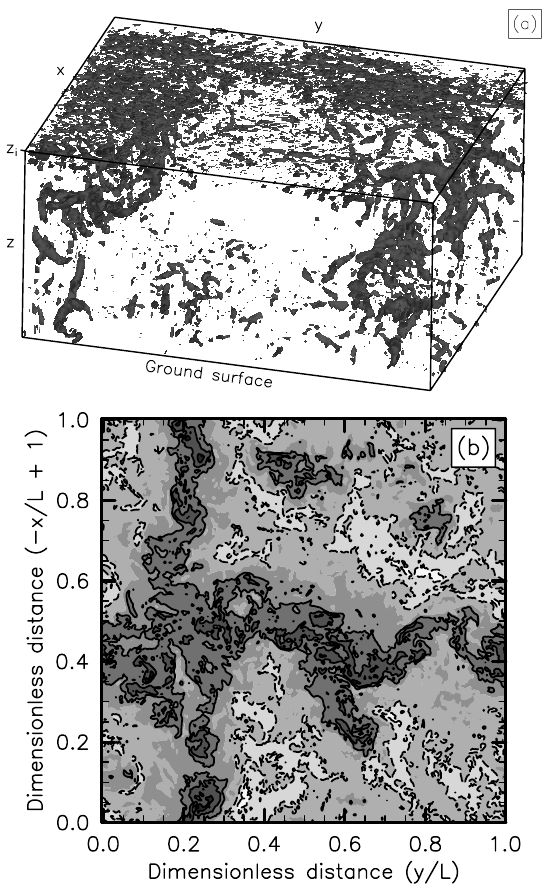
Fig. 3. (a) Iso-surface Q =0.0015s − 2 for an isolated convective cell at 15:00EST. The displayed view encompasses a horizontal domain of about 1.5km × 1.5km, the height ranging from z =0 to z i . (b) Contour plot of the dimensionless vertical velocity e w/w ∗ at the same time in the horizontal plane z = z i / 2. At the displayed time, w ∗ =1.70ms − 1 and z i =1300m. The contour lines correspond to =± 1, ± 2, ... Solid and dashed lines represent positive and e w/w ∗ negative contour values, respectively, with darkest zones being as- sociated with updrafts and lightest with downdrafts. The distances along x and y are normalized by the domain length L . The structure visible in Fig. 3a has a horseshoe shape, which is clearly visible in Fig. 3b for approximately 0 . 2 ≤ y ≤ 0 . 6 and 0 . 2 ≤ ( − x/L + 1 ) ≤ 0 . 6.